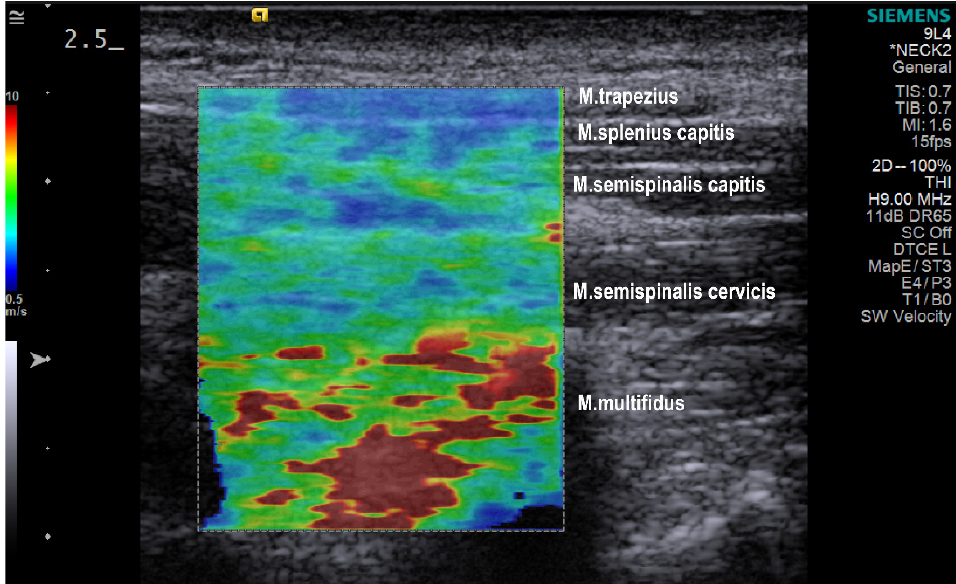
Figure 1. Color-coded elastography shear wave image with muscle layer